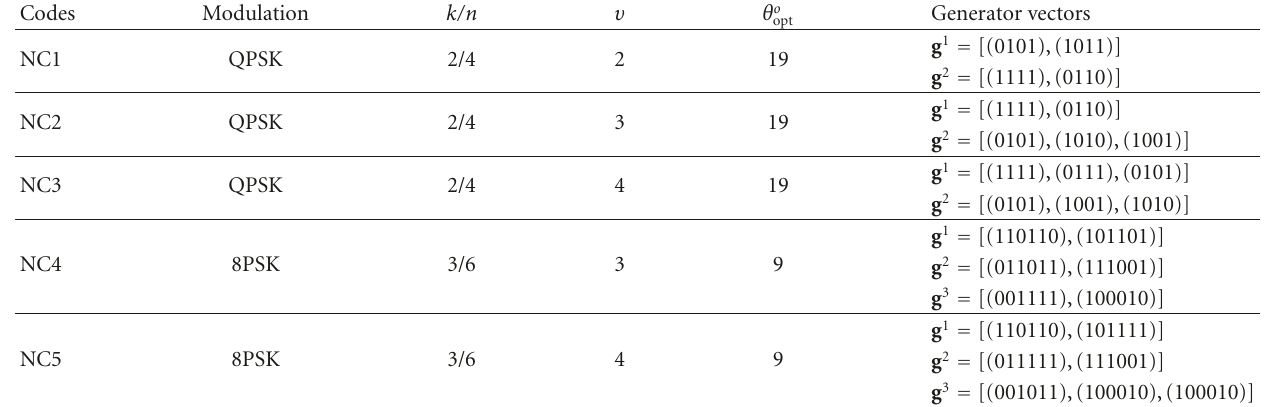
Table 1: Generator vectors for cooperative trellis